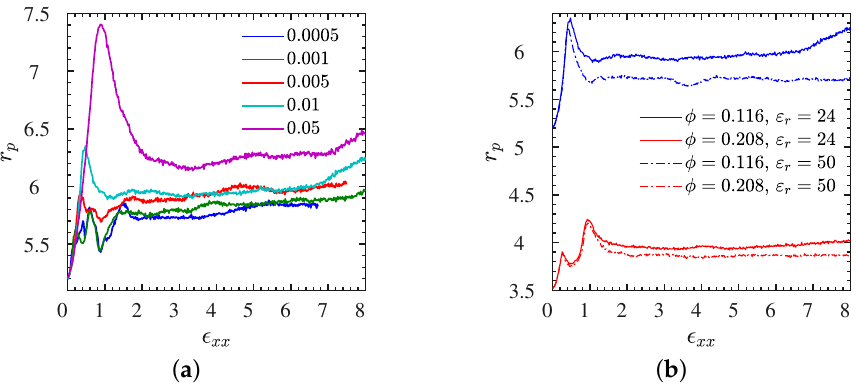
Figure 10. Pore radius data for all L systems. ( a ) Dependence of the mean pore radius r p on stretching rate ˙ (cid:101) xx for the L1 • system at various rates. ( b ) r p dependence on φ and ε r measured at a stretching rate of ˙ (cid:101) xx = 0.01. The corresponding stress–strain curves are given in Figures 2a and 4a respectively. Analogous analysis for the S systems in Supplementary Figure S9a for S1 • and in Figure S9b for all S